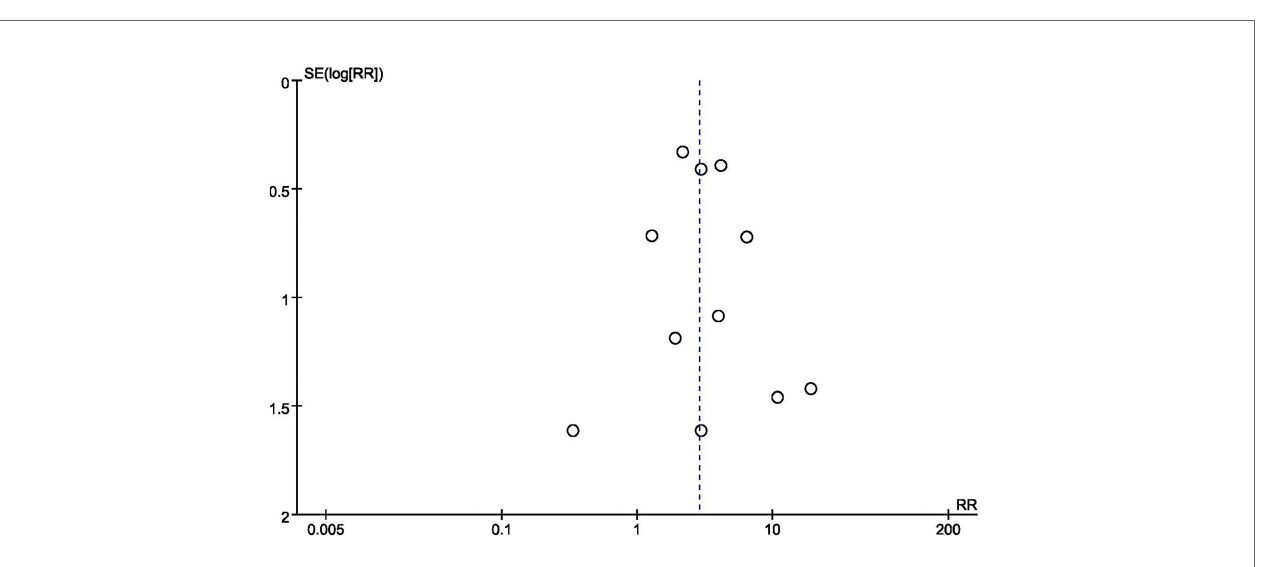
FIGURE 5 | Funnel plot of clinical pregnancy